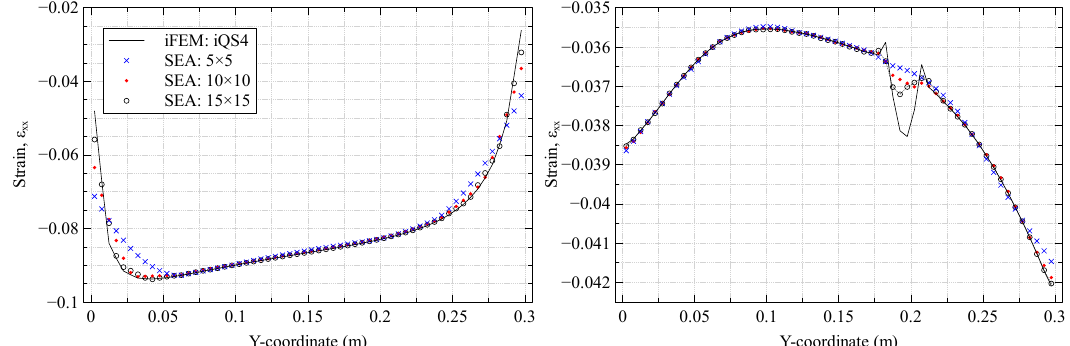
Figure 5. iFEM and SEA results (using α = 1000) for various smoothing meshes compared along ( left ) the plate root ( x = 2.5 mm) and ( right ) across the delamination ( x = 162.5 mm).